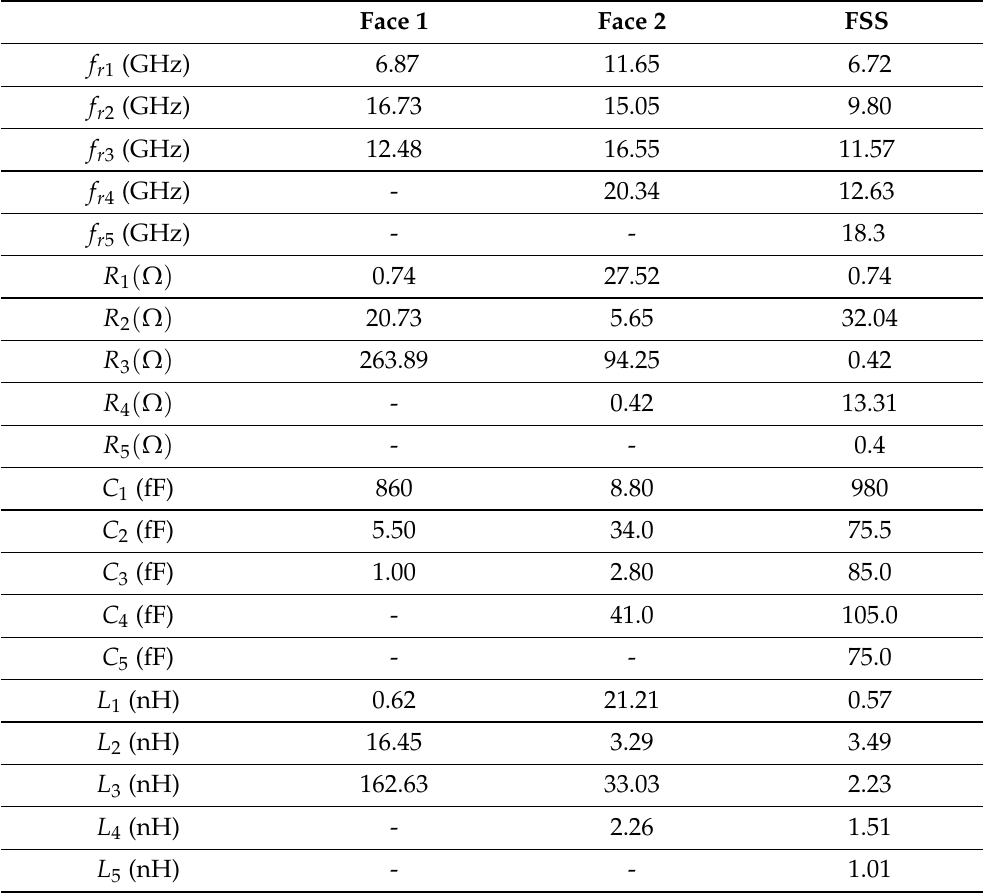
Table 1. Elements of the circuit models for the unit